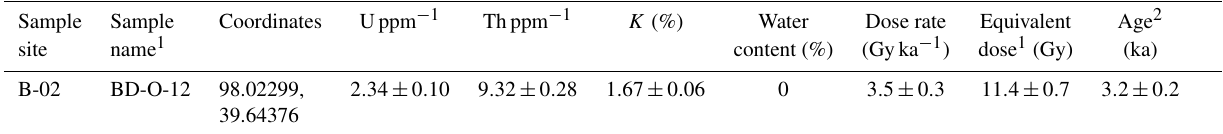
Table 3. OSL age of loess covering terrace